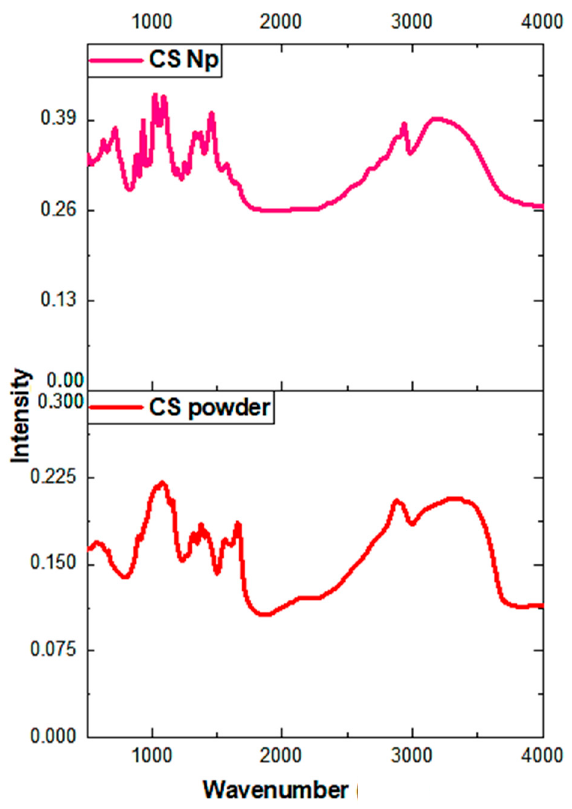
Figure 4. Fourier-transform infrared spectroscopy ( FTIR) spectra of chitosan nanoparticles and chitosan powder. chitosan